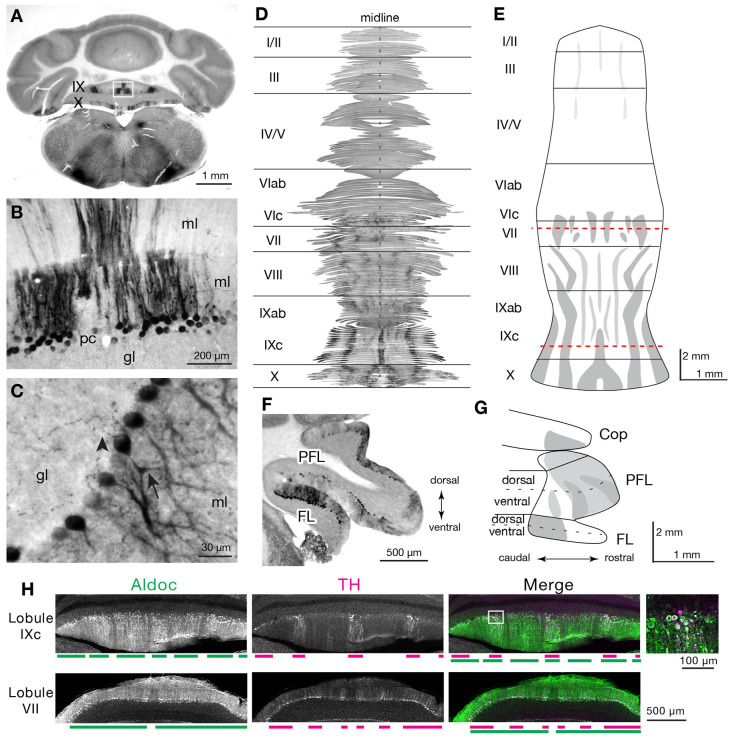
Immunostaining for Th reveals the striped distribution of the Th+ Purkinje cells (PCs) in the cerebellar cortex of the posterior vermis and parafloccular/floccular complex. (A) Immunostaining for Th reveals physiological Th expression in the cerebellum. Expression in lobules IX and X are shown in the coronal section. (B) Robust immunoreactivity for Th is identified in a subset of Purkinje cells that are arranged in parasagittal stripes. Cell bodies and dendrites of these PCs were labeled. ml, molecular layer; pc, Purkinje cell layer; gl, granule cell layer. (C) High magnification of Th+ PCs demonstrates Th+ puncta (arrowhead) that are in close apposition to PCs. Purkinje cell bodies and apical dendrites (Arrow) again show intense immunoreactivity for Th. ml, molecular layer; pc, Purkinje cell layer; gl, granule cell layer. (D) Serial section alignment analysis for the entire vermal cortex to visualize stripes of Th+ PCs. The result demonstrates an unfolded flat map of the vermal cortex reconstructed from the serial cerebellar sections immunostained for Th (see “Materials and Methods” section). (E) Schematic representation of the striped distribution of the Th+ vermal PCs. Drawn from the analysis in panel (D). Red dotted lines indicate the approximate location of the images in panel (H). (F) Th-immunoreactive PCs identified in the parafloccular/floccular (PFL/FL) complex. (G) Schematic representation of the distribution of the Th+ parafloccular/floccular PCs. (H) Double immunostaining for Th and Aldoc of cerebellar sections. Colabeling of Th (magenta) and Aldoc (green) is revealed in a subset of Aldoc+ Purkinje cells. Images of lobules IXc or VII, at levels indicated in (B), are shown. Below each panel is magenta and green bars that represent striped expression patterns of Th and Aldoc, respectively. Inset shows a higher magnification image of PCs, at an area marked with a white rectangle, that is colabeled with Th and Aldoc.